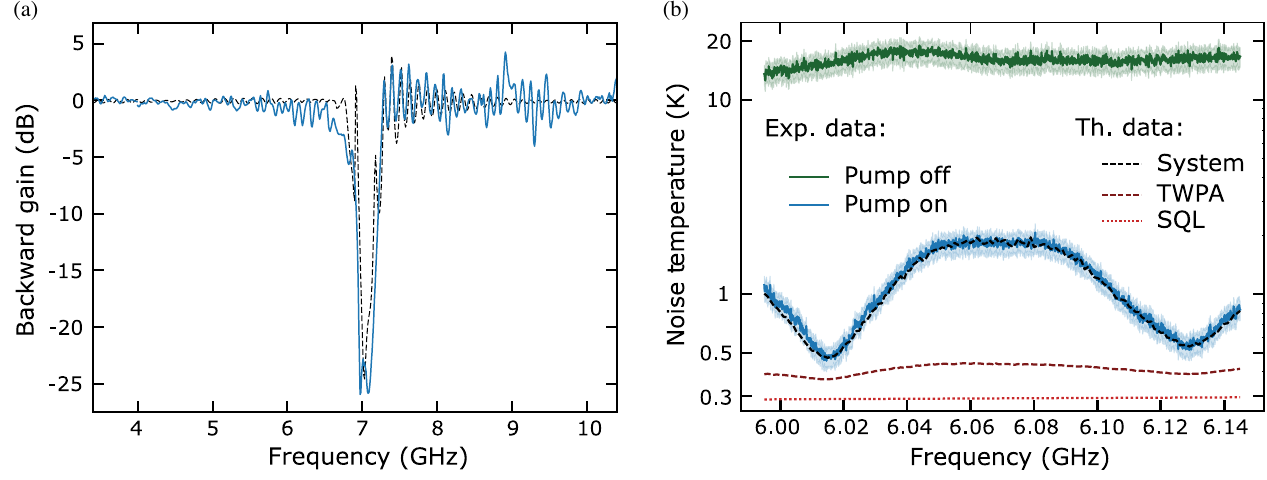
FIG. 4. (a) Backward gain measured with Φ = Φ 0 ¼ 0 . 1 and pump frequency 6.9108 GHz. Expected gain is plotted for a pump power ¼ − 71 . 4 dBm. (b) Noise temperature of the STWPA. Measured PSD normalized by the system gain when the STWPA pump is P input off (green solid line, the light green area corresponds to error bars) or on (blue solid line, the light blue area corresponds to error bars). The red dotted line corresponds the standard quantum limit (SQL) of noise. The brown dashed line refers to the intrinsic noise of the STWPA, which is slightly above the SQL because of internal losses. The black dashed line is the total calculated system noise temperature. It is higher than the STWPA intrinsic noise temperature because of the finite STWPA gain. Noise ripples are caused by STWPA gain ripples. Theory curves also have error bars since they rely as well on a careful calibration of the total system gain. For the brown dashed line, it is between 40 mK (gain peak) and 50 mK (gain dip). For the black dashed line, it is between 60 and 260